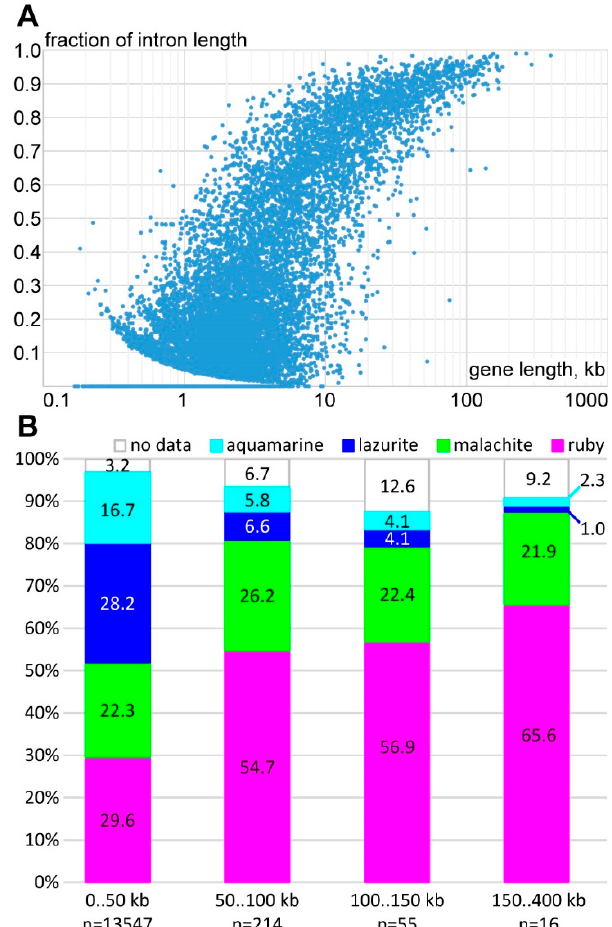
Figure 1. The distribution of introns and different chromatin states according to 4HMM model [39]. (A) fraction of intron length according to the gene length in kb; and, (B) distribution of four chromatin states in genes with length <2, 2-50, 50-100, and >100 kb).